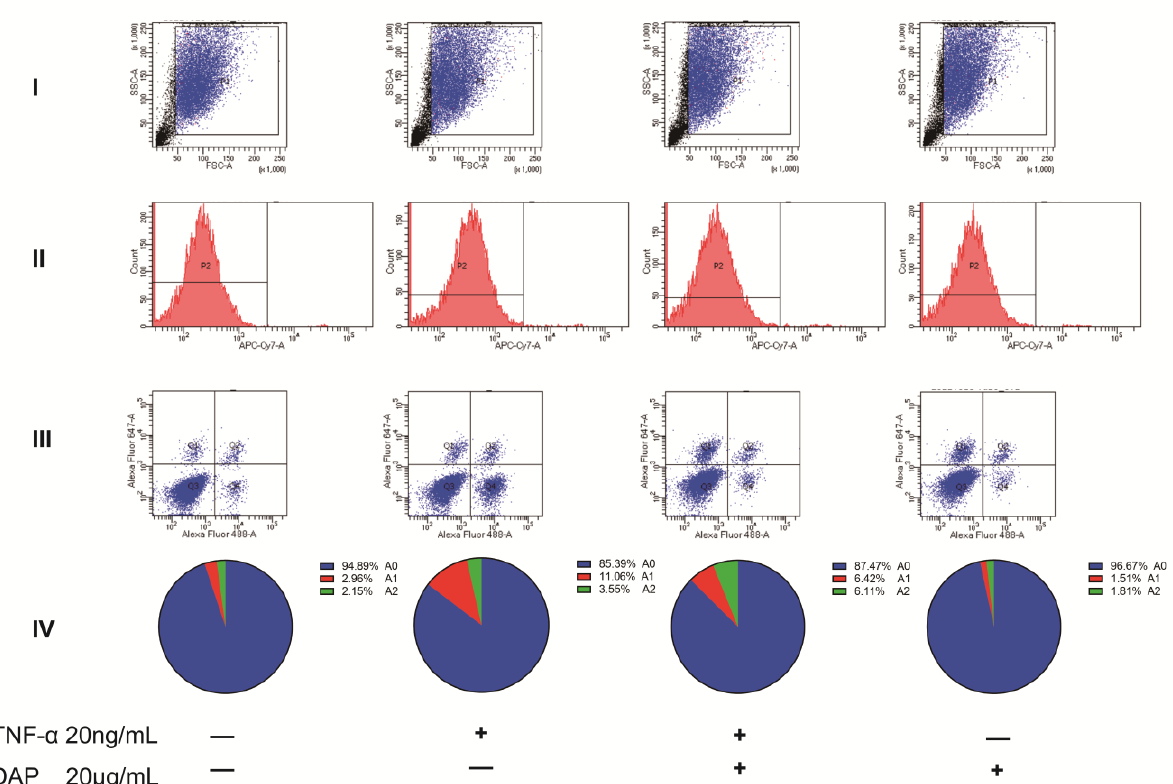
Figure 9. Effect of daphnetin on the TNF −α− induced polarization of U251 cells. ( I ) The range of cells circled by flow cytometry. ( II ) Negative region P2 and positive region P3 of Zombie NIR. ( III ) Expression of C3 and S100A10 in cells within the P2 region. ( IV ) Percentage expression of A0, A1, and A2 within the samples by flow cytometry ( n = 6).